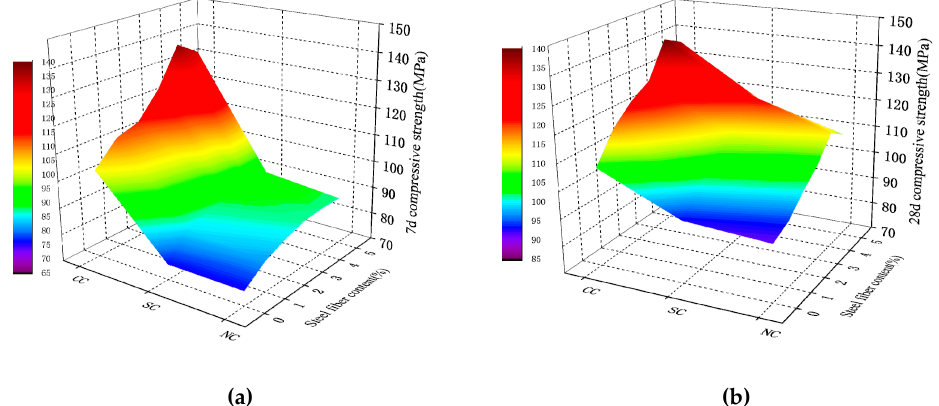
Figure 10. Compressive strength of steel fiber RPC with di ff erent dosages: ( a ) 7-day and ( b ) 28-day Figure 10 . Compressive strength of steel fiber RPC with different dosages: ( a ) 7-day and ( b ) 28-day